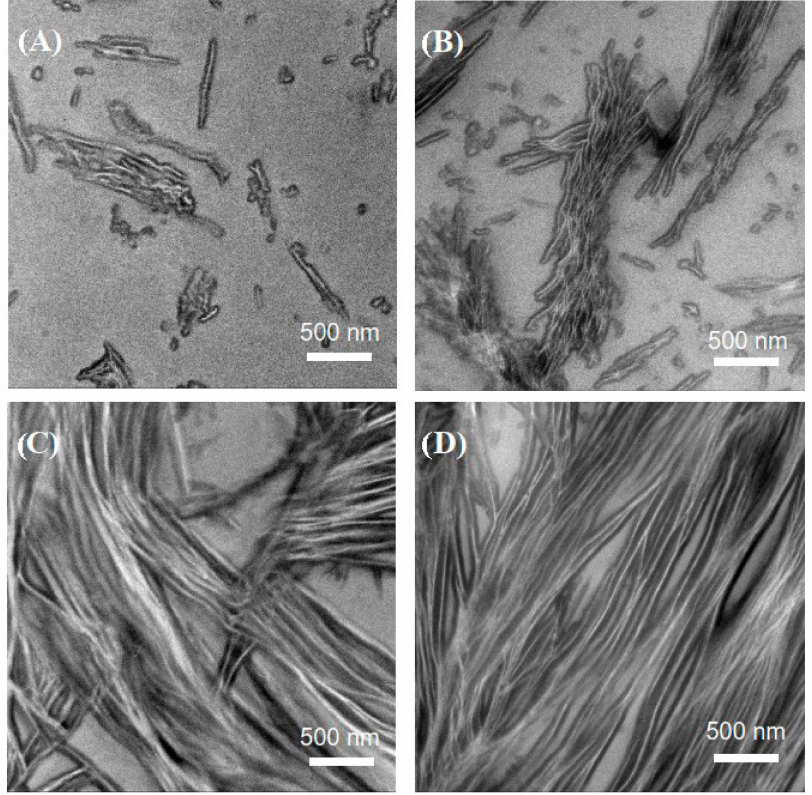
Figure 5. TEM images of epoxy thermosets containing ( A ) 5, ( B ) 10, ( C ) 15 and ( D ) 20 wt% of PCL -b- PE -b- PCL via